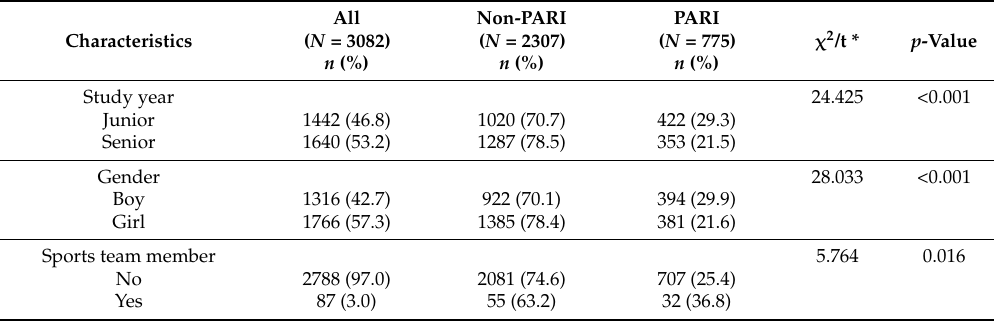
Table 1. Comparison of socio-demographic characteristics and other main factors in participants with physical activity-related injury (PARI) or